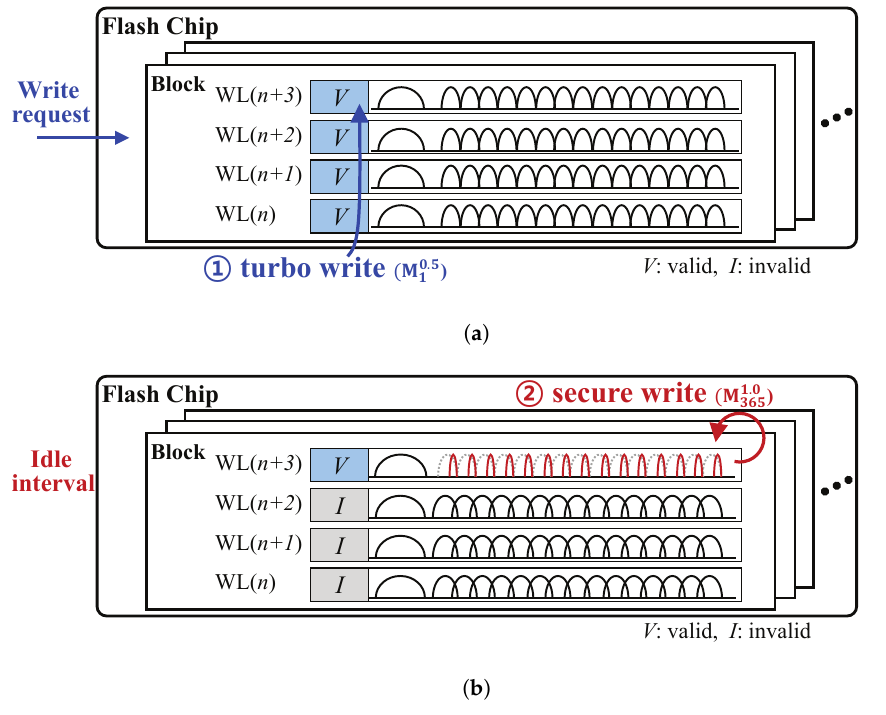
Figure 4. An operational overview of the LazyRS scheme. ( a ) Stage_t: turbo program phase. ( b ) Stage_s: secure program